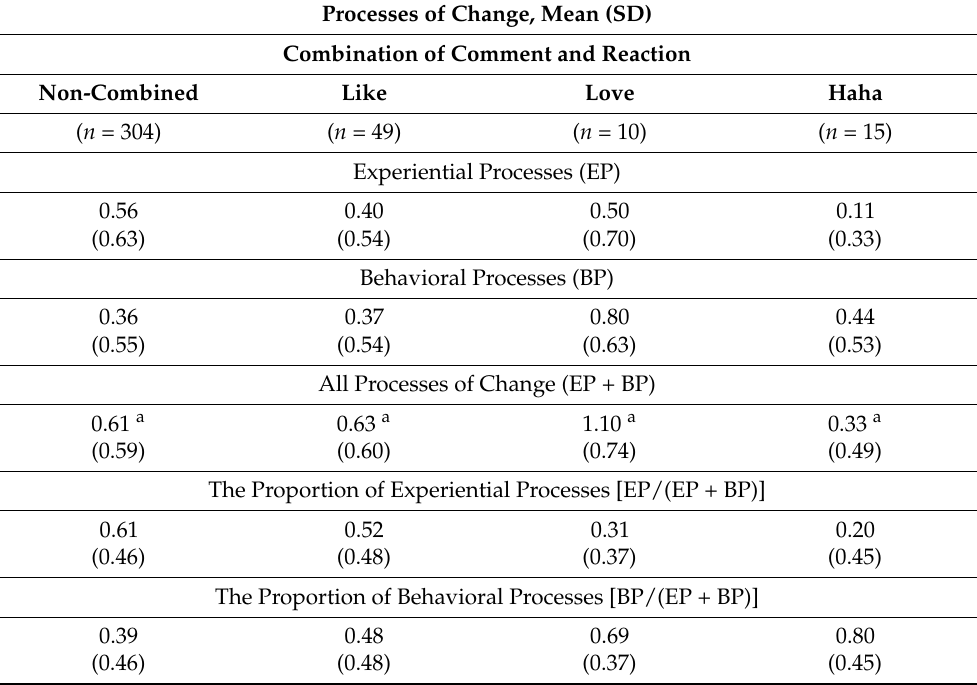
Table 2. The mean and the SD for the processes applied in the Transtheoretical Model by the combination of comments with